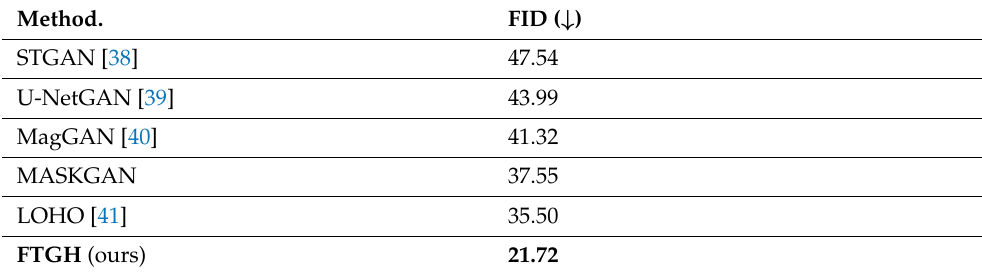
Table 2. Comparison of FID of different models.